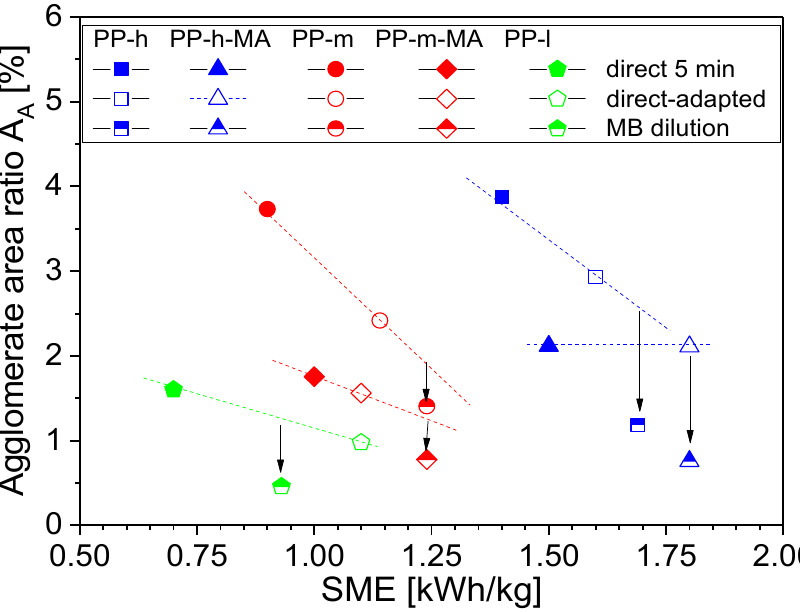
Figure 4. State of macro dispersion (A A ) vs. SME for PP/2 wt % MWCNT composites prepared using different conditions, lines and arrows are only for guiding the eyes.